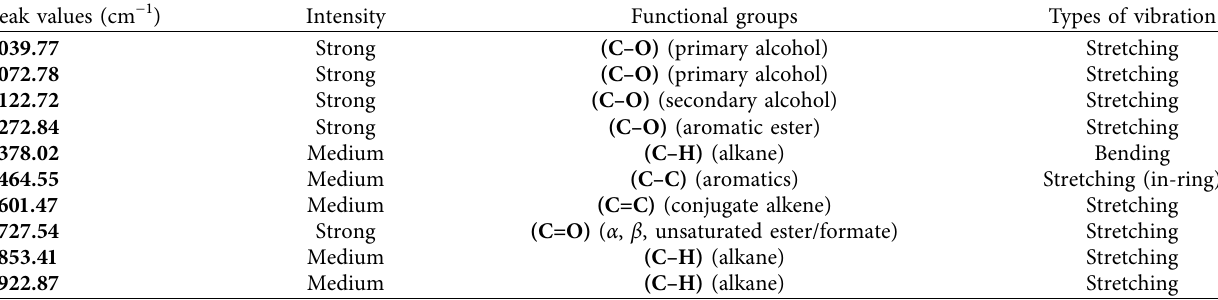
Table 8: IR spectrum of functional groups present in DO5 bioactive fractions.